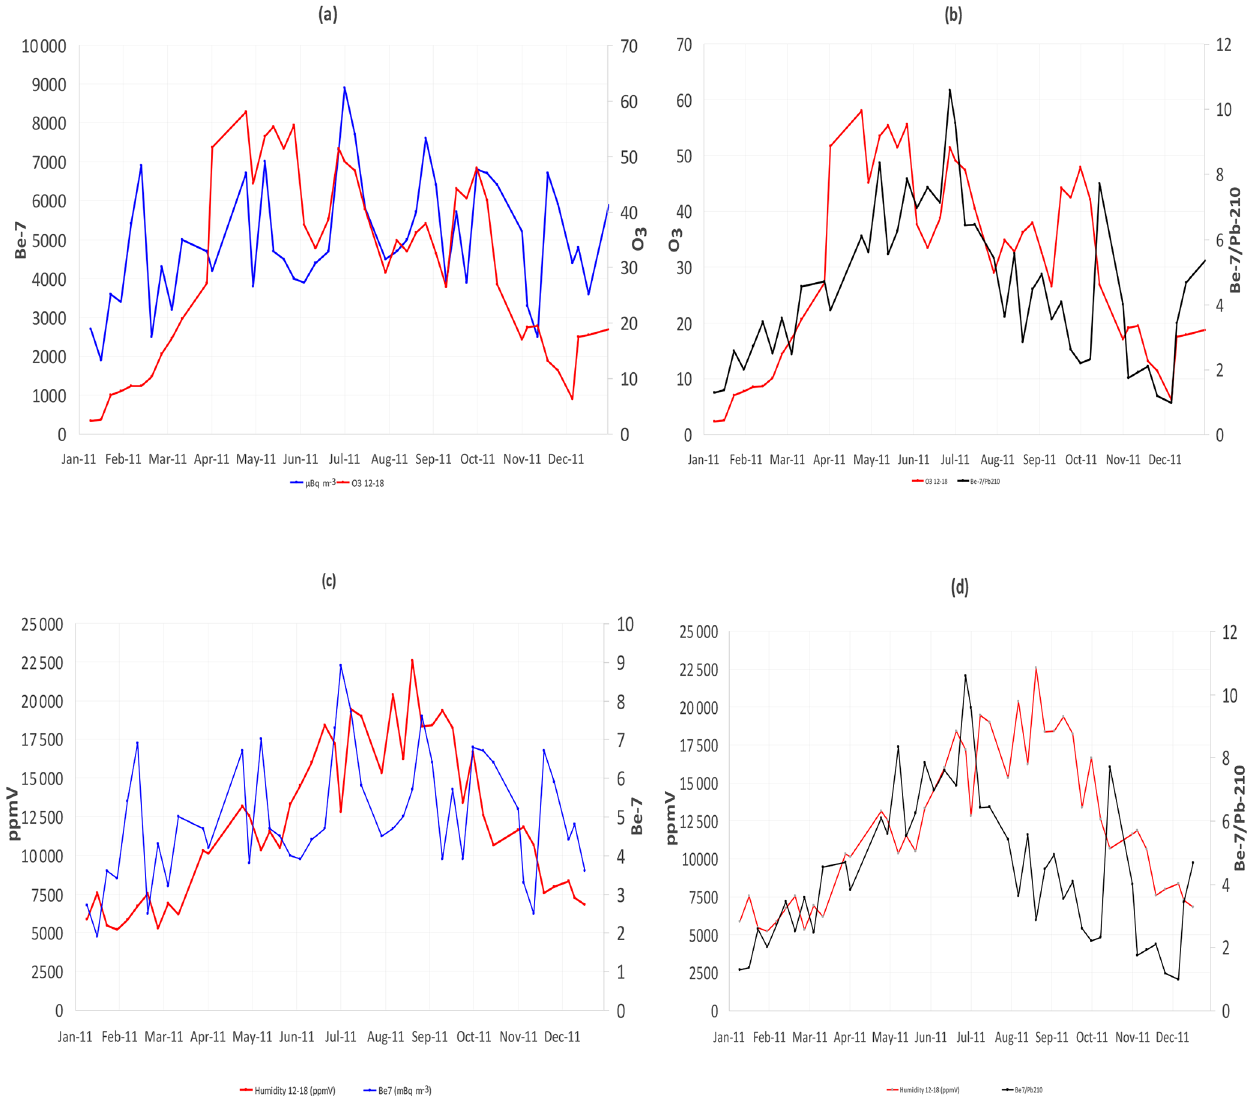
Figure 1. (a) Weekly averages for ozone at 12:00–18:00 (ppb, red) and 7 Be (µBqm − 3 , blue) at the JRC Ispra station for 2011. The authors acknowledge the use of a similar figure in Jensen et al., 2017 (see the “Acknowledgements” section for more details). (b) Weekly averages for ozone at 12:00–18:00 (ppb, red) and 7 Be / 210 Pb ratio (black) at the JRC Ispra station for 2011. The authors acknowledge the use of